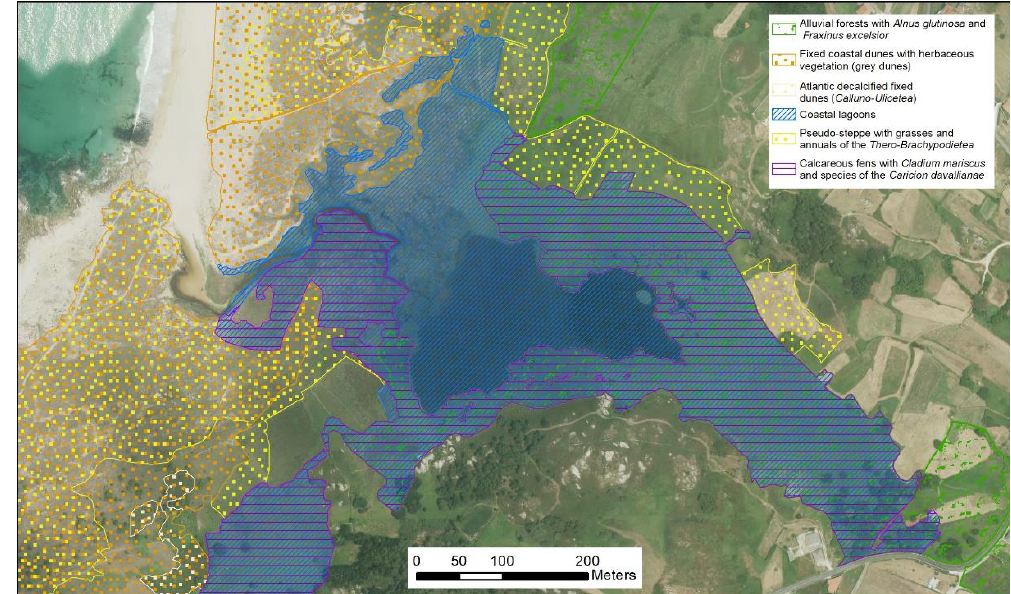
Figure 5. Vixán lagoon with the main habitats defined by Plan Director Rede Natura 2000 (PDRN). Data: Xunta de Galicia © . Areas with multiple patterns correspond with zones with various main categories.